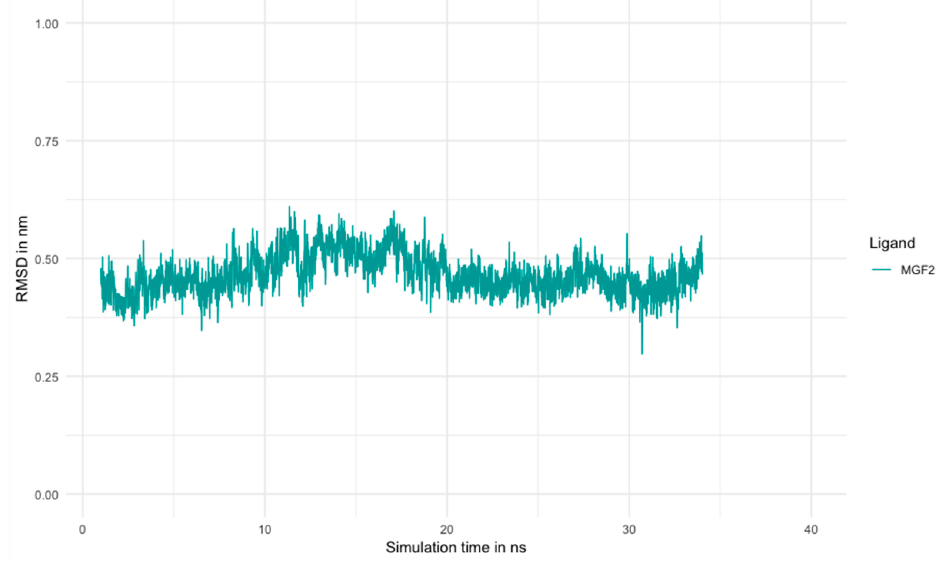
Figure 3. Illustration of the result of molecular dynamics demonstrating the evolution of the distance between residues during the time of stimulation (35 ns).